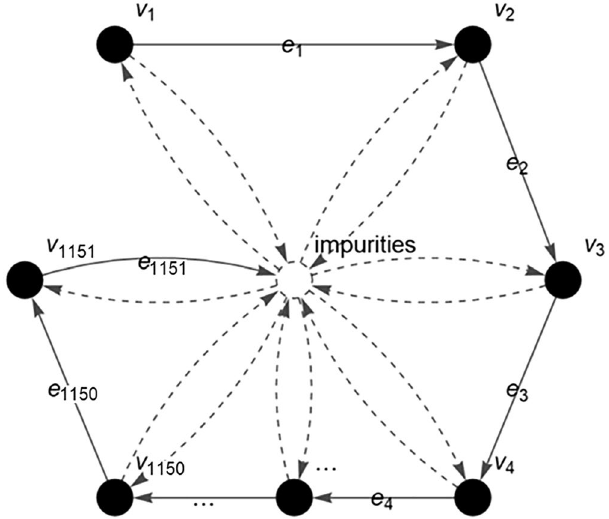
Figure 10. The FACS graph of RM50 banknotes’ spectra at wavenumbers of 1800–650 cm −1 .